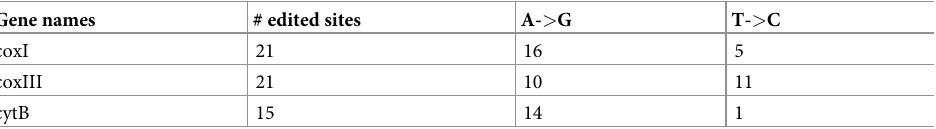
Table 1. Differences between the genomic and expressed versions of mitochondrial genes found in Amoebophrya sp. ex Karlodinium veneficum